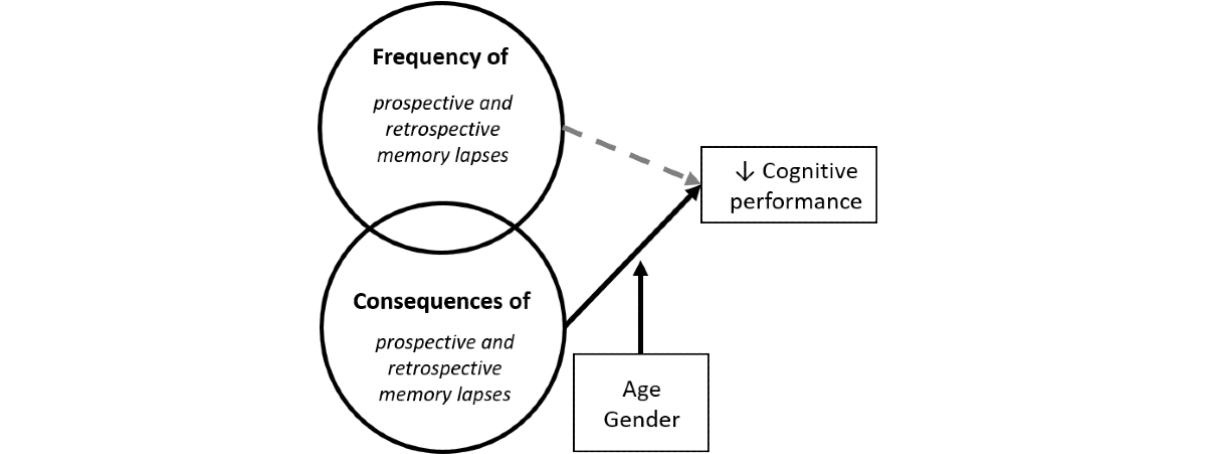
Figure 2. Conceptual model of this study’s